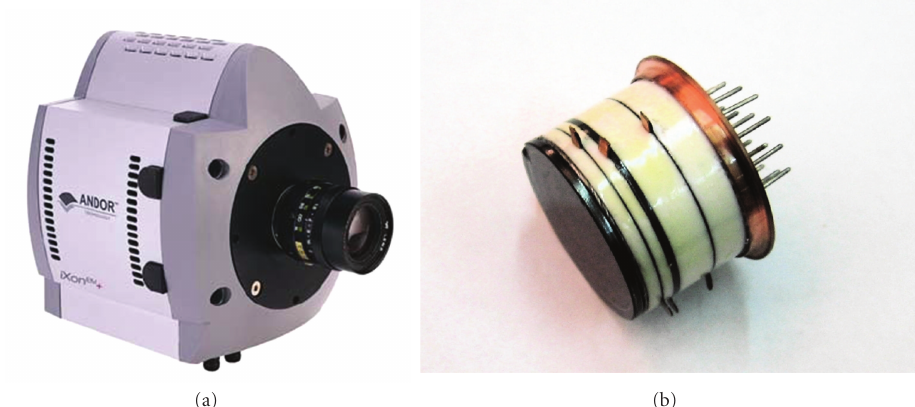
Figure 3: Two possible photodetectors which may be used in FUSP. (a) iXon EM +888 EM-CCD from Andor. (b) Position-Sensitive Detector with GaAs-photocathode, developed at Special Astrophysical Observatory of Russian Academy of